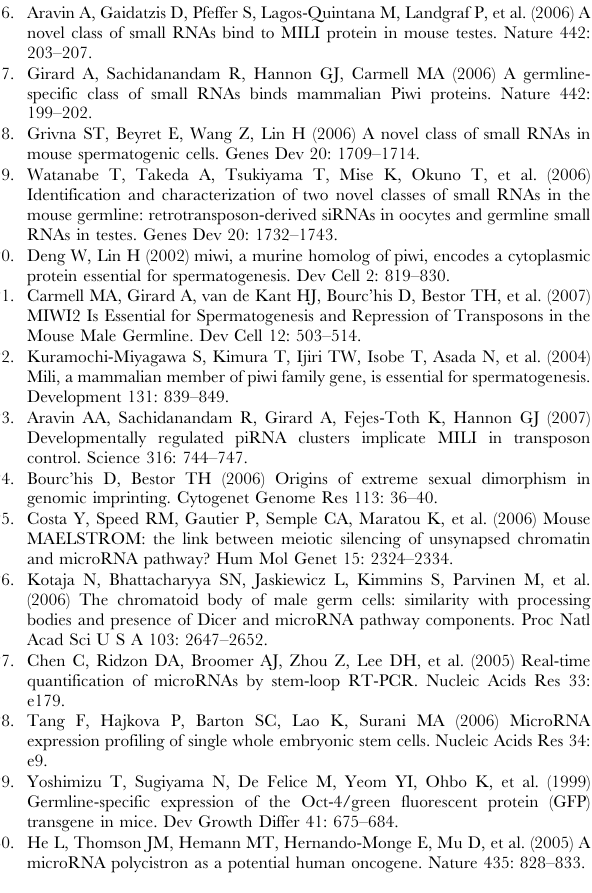
methods) and then loaded in an agarose gel. PCR products corresponding to each allele are indicated by arrowheads. Bars and the numbers below the gel image indicate the relative intensities between bands from F and deleted allele. (B) Expression levels of Dicer in E13.5 sorted male PGCs. Relative expression levels of Dicer were calculated by dividing with those of Gapdh. DicerF/ + TNAP-Cre fetuses were used as the controls. Found at: doi:10.1371/journal.pone.0001738.s003 (0.37 MB TIF) Figure S4 Comparable level of apoptotic cells in DicerCKO PGCs at E13.5. Immunofluorescence analysis for Mvh (green), apoptotic cells (red) and nuclei (blue) in E13.5 DicerCKO and littermate control gonads. Two images are randomly chosen from each genotype. Scale bar; 50 m m Found at: doi:10.1371/journal.pone.0001738.s004 (1.54 MB TIF) Figure S5 DNA methylation in LINE-1 and IAP sequences in E13.5 DicerCKO PGCs. Bisulfite sequencing profiles of LINE-1 and IAP sequences are shown with filled (methylated) and open (unmethylated) circles. Gaps in the methylation profiles represent mutated or missing CpG sites. The numbers under the bisulfite sequencing profiles show the percentages of methylated CpG. Found at: doi:10.1371/journal.pone.0001738.s005 (0.26 MB TIF) Figure S6 Defective spermatogenesis in DicerCKO testes. (A) Hematoxylin and eosin (HE)-stained testicular sections from 4 weeks-old DicerCKO and littermate control males. Spermatogen- ic cells in DicerCKO testis are fewer than those in littermate control. (B) HE-stained (left) and immunostained (right) testicular sections from 8 month-old DicerCKO and littermate control